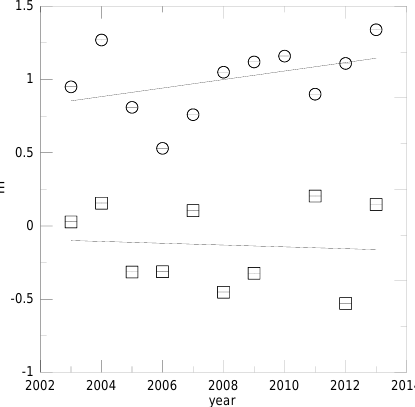
Figure 4. Annual averages of precipitation intensity (m, circles) and NAO (squares). The straight lines are least squares